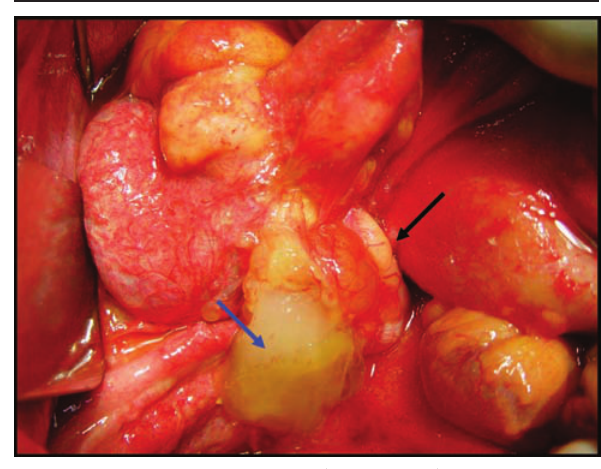
FIGURE 2 - Mucoid pattern (blue arrow) in contact with the cecal appendix (black